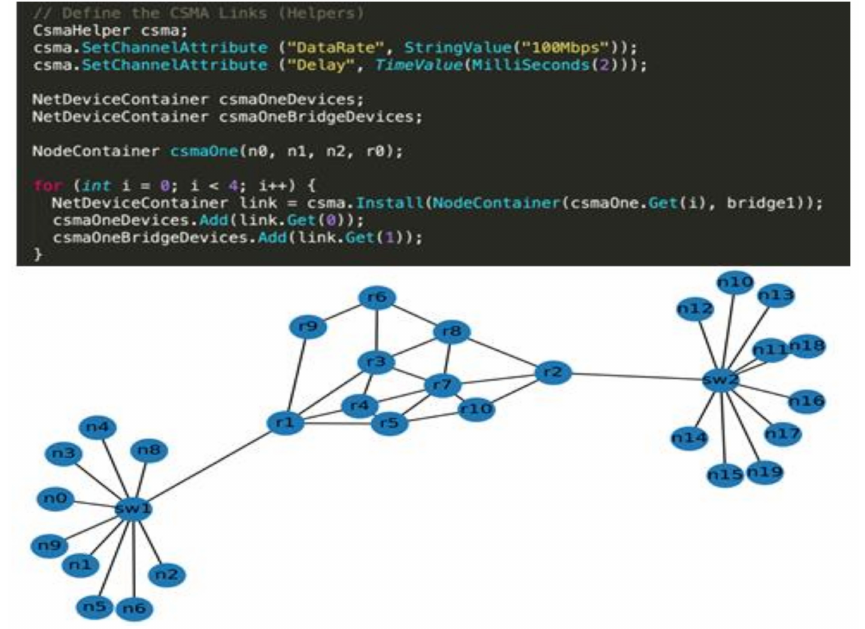
Figure 11. Simulated network topology specified by the Boston University Representative Internet Topology Generator (BRITE) framework (number of nodes =